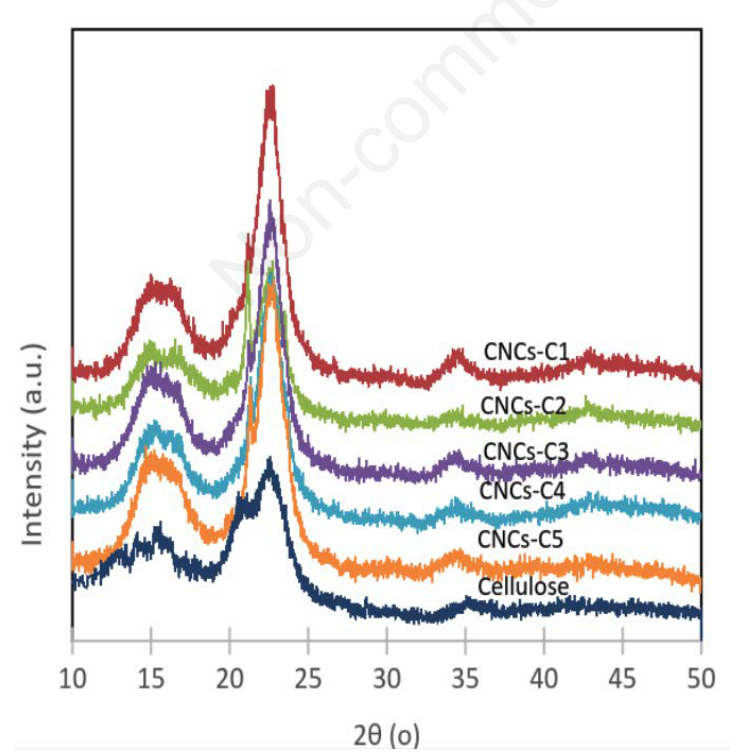
Figure 1. XRD of cellulose and CNCs are hydrolyzed with a reaction time of 1 to 5 hours.